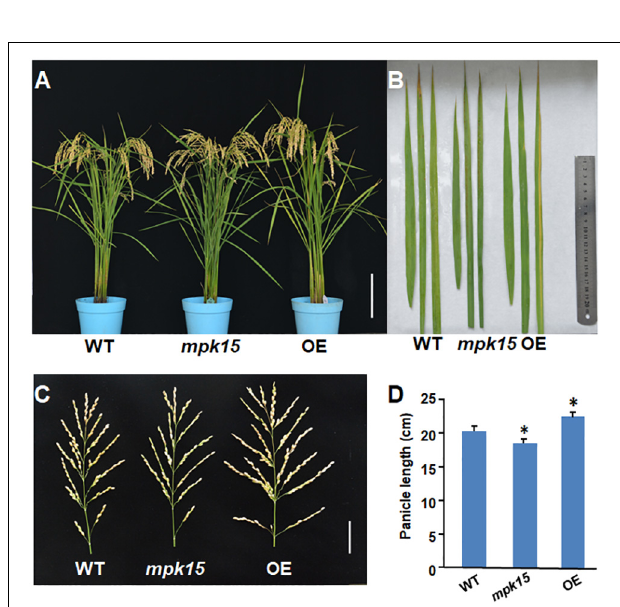
FIGURE 2 | Phenotypic comparison of the WT, mpk15 mutant, and OsMPK15-OE lines. (A) The phenotype of the WT, mpk15 mutant, and OsMPK15-OE lines at 102 days post-sowing (dps). Bars indicate a length of 15 cm. (B) Magnified view of the flag leaf, top second, and top third leaves in the WT, mpk15 mutant, and OsMPK15-OE line at 102 dps. Among them, the top third of OsMPK15-OE has obvious bacterial blight lesion. (C,D)